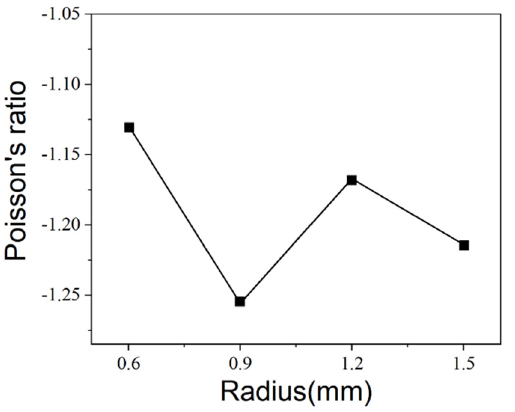
Figure 5. Poisson’s ratio for the four models without rings. Table 3. Comparison of Poisson’s ratios for models with and without